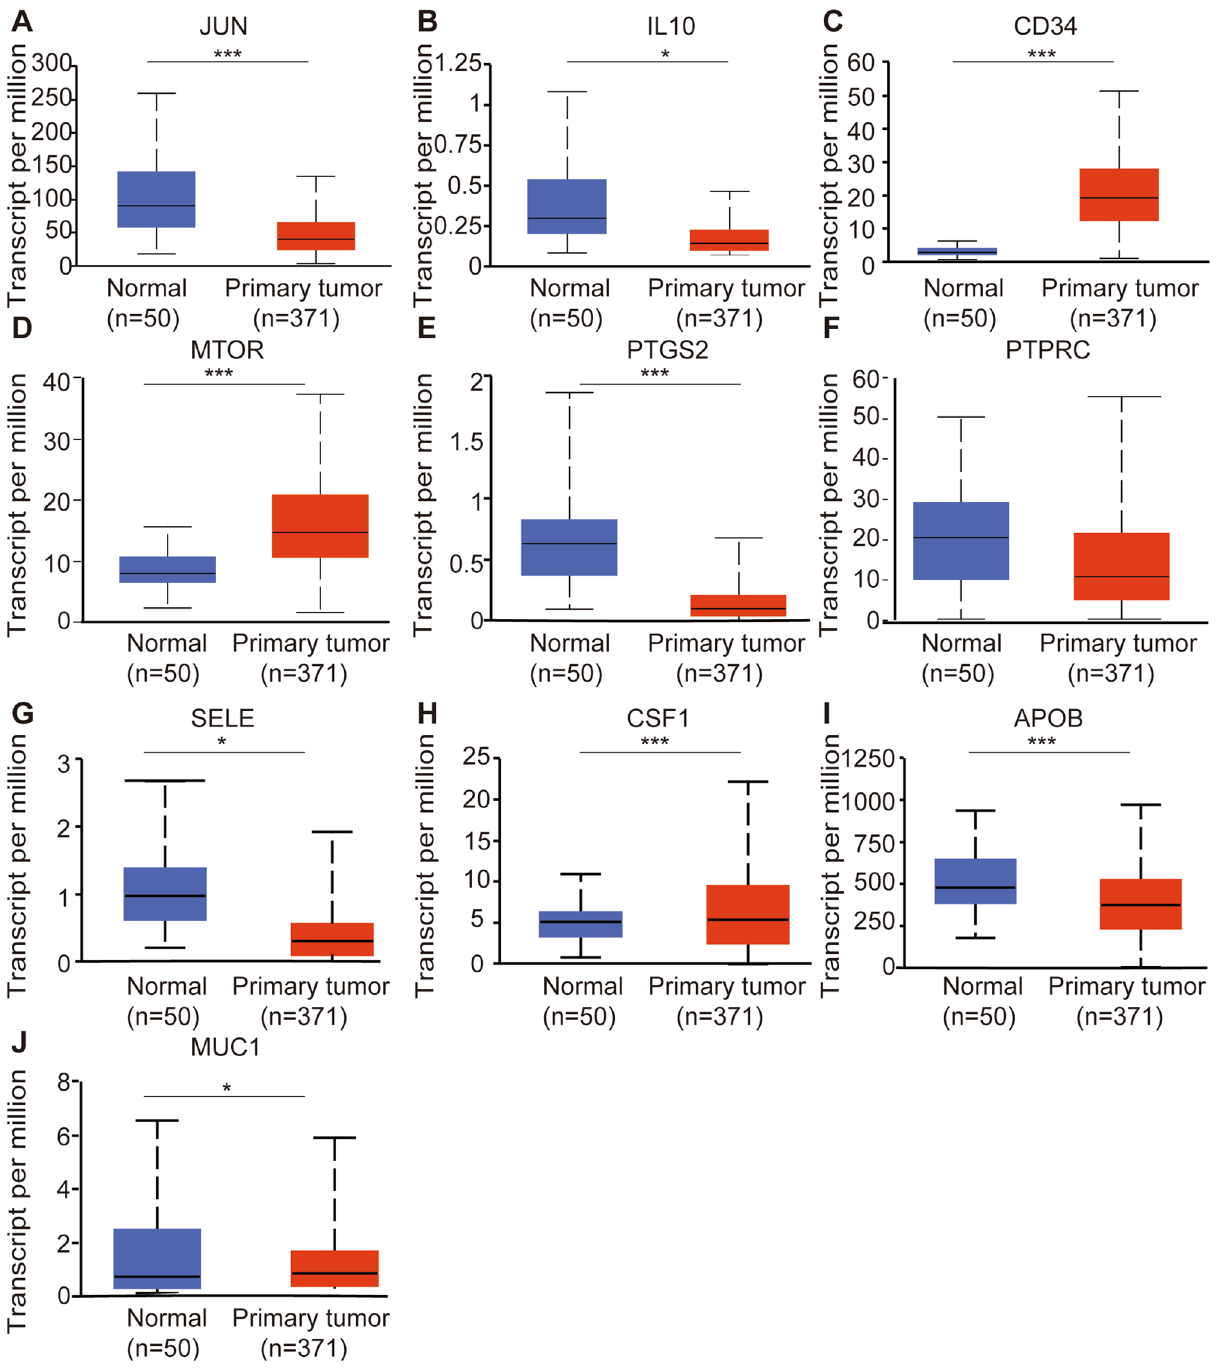
Figure 3. mRNA expression of hub genes in HCC tissues and adjacent normal liver tissues. ( A ) JUN, ( B ) IL10, ( C ) CD34, ( D ) MTOR, ( E ) PTGS2, ( F ) PTPRC, ( G ) SELE, ( H ) CSF1, ( I ) APOB, ( J ) MUC1. *P < 0.05, **P < 0.01, ***P <